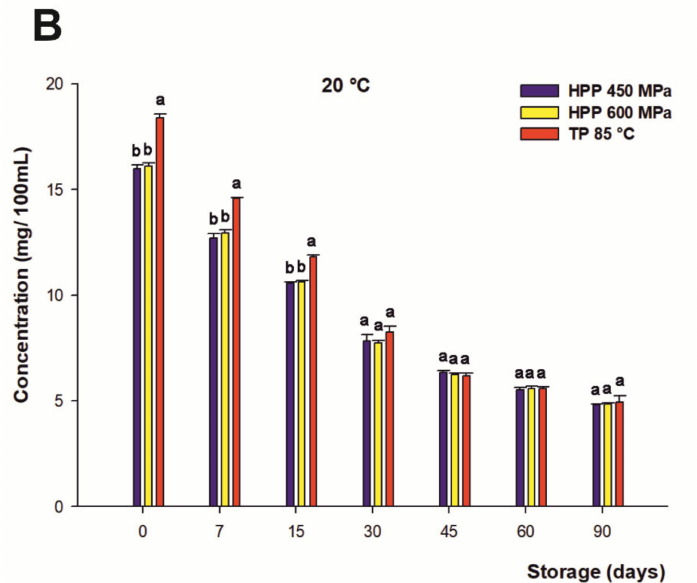
Figure 3. Changes in content of total anthocyanins (mg/100 mL) of juices subjected to high hydro- static pressure (HHP—450 and HHP—600 MPa) and thermal pasteurization (TP—85 ◦ C), measured during storage for 90 days in refrigerated conditions at 4 ◦ C ( A ) and 20 ◦ C ( B ) under darkness conditions. Bars with different lowercase letters within each time point were different statistically at p < 0.05 according to the analysis of variance (ANOVA) and Tukey’s multiple range